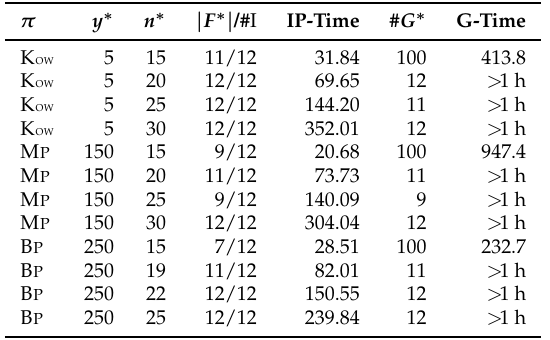
Table 4. Results of Steps 4 and 5 with d max = 4 and θ = −